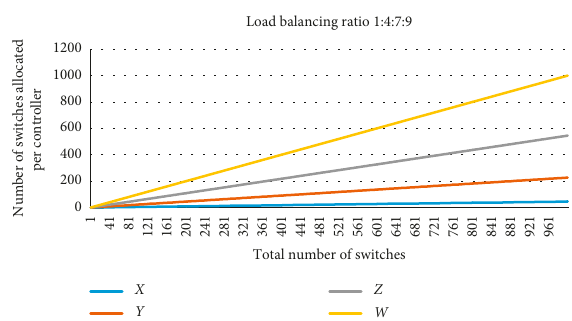
Figure 9: Load balancing for four slave controllers with ratios 1 :4: 7:9. Load balancing ratio 2:4:6:8